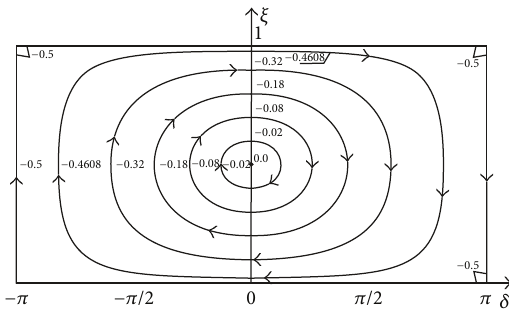
Figure 10: Phase portrait for the case of 1:1 internal resonance 𝜔 1 = 𝐾 (𝑏𝐸 ) −1 = 1 and 𝐾 𝜔 3 at 2 0